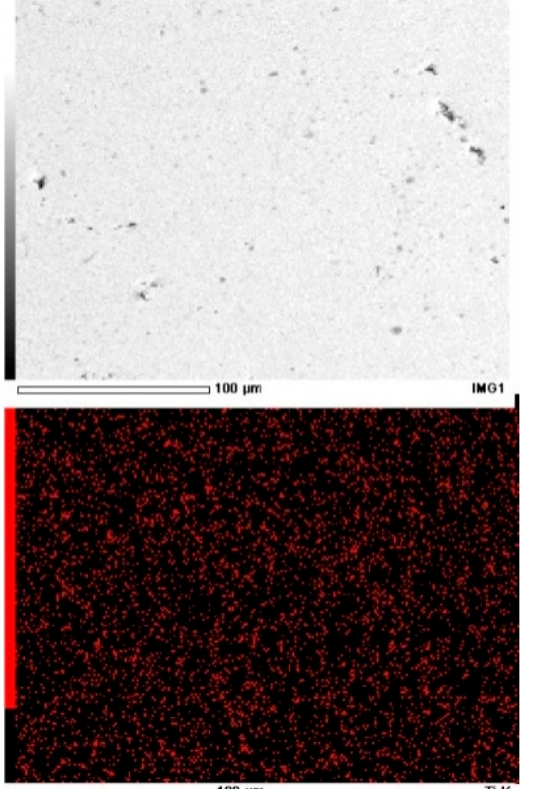
Figure 3. SEM images of duplextube.